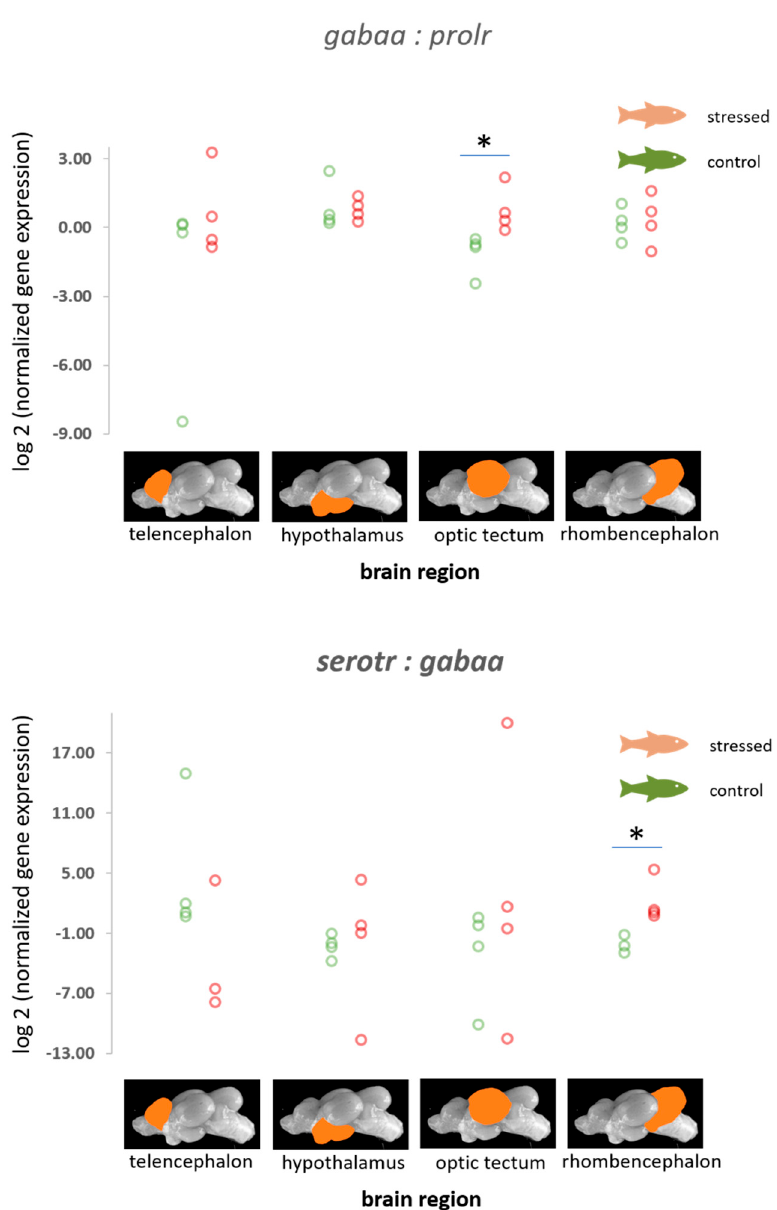
Figure 4. Ratios of the normalized fold expression of gabaa to prolr and the normalized fold expression of serotr to the expression of the gabaa gene in each of the four brain parts in the control fish and fish 30 min after the air exposure with 95% confidence intervals of − 2.43 to − 0.63 for the control and 0.105 to 1.813 for the stressed fish for the gabaa:prolr ratio in the optic tectum, and − 2.92 to − 1.49 for the control and 0.95 to 4.39 for the stressed fish for the serotr:gabaa ratio in the rhombencephalon derived from the adjusted bootstrap percentile (BCa) method; n = 4 per treatment, * = significance according to the Mann–Whitney U tests, p < 0.05.